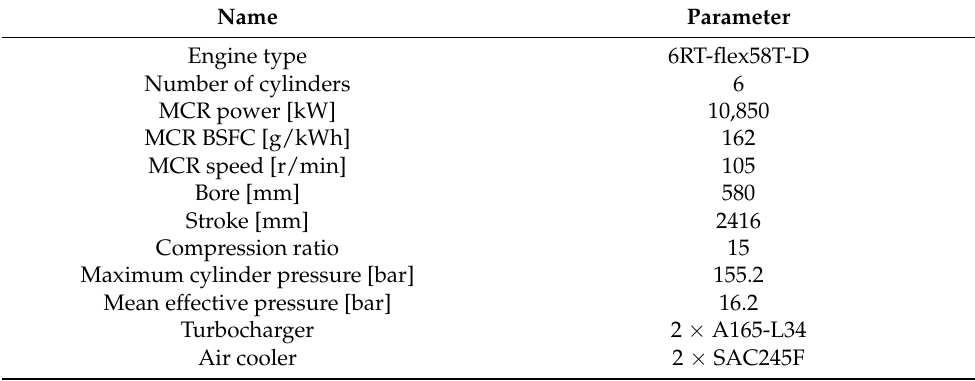
Table 2. Fuel characteristics of diesel oil.